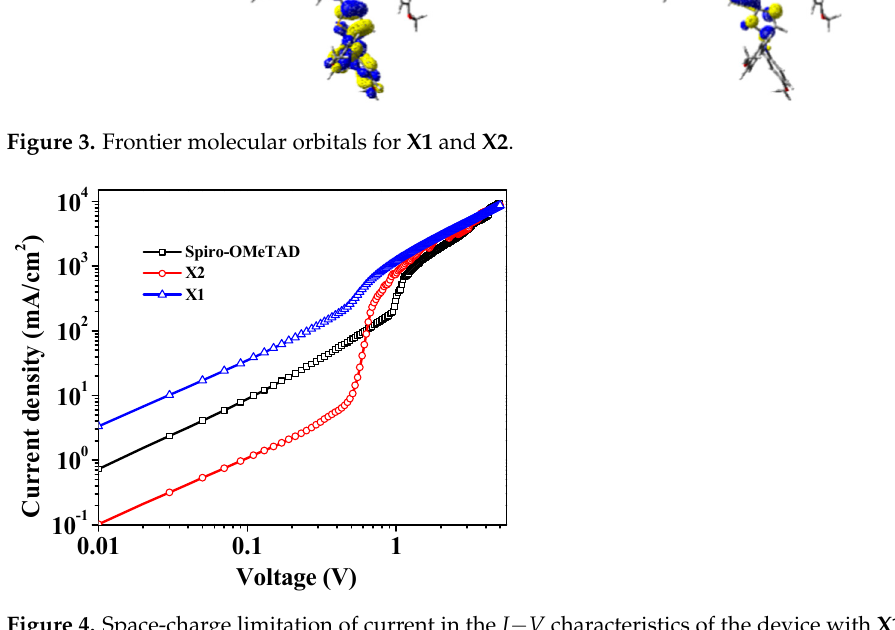
Figure 4. Space-charge limitation of current in the J − V characteristics of the device with X1 , X2 , and Spiro-OMeTAD HTMs.